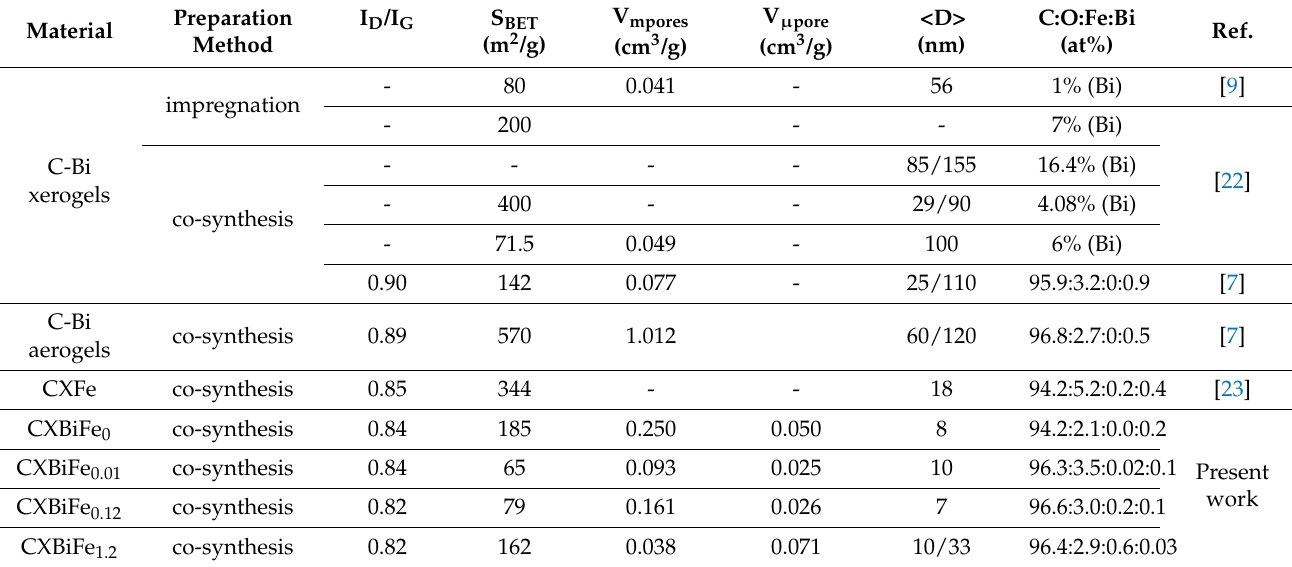
Table 1. Summary of morphological and structural parameters obtained for the synthesized samples and other similar materials.